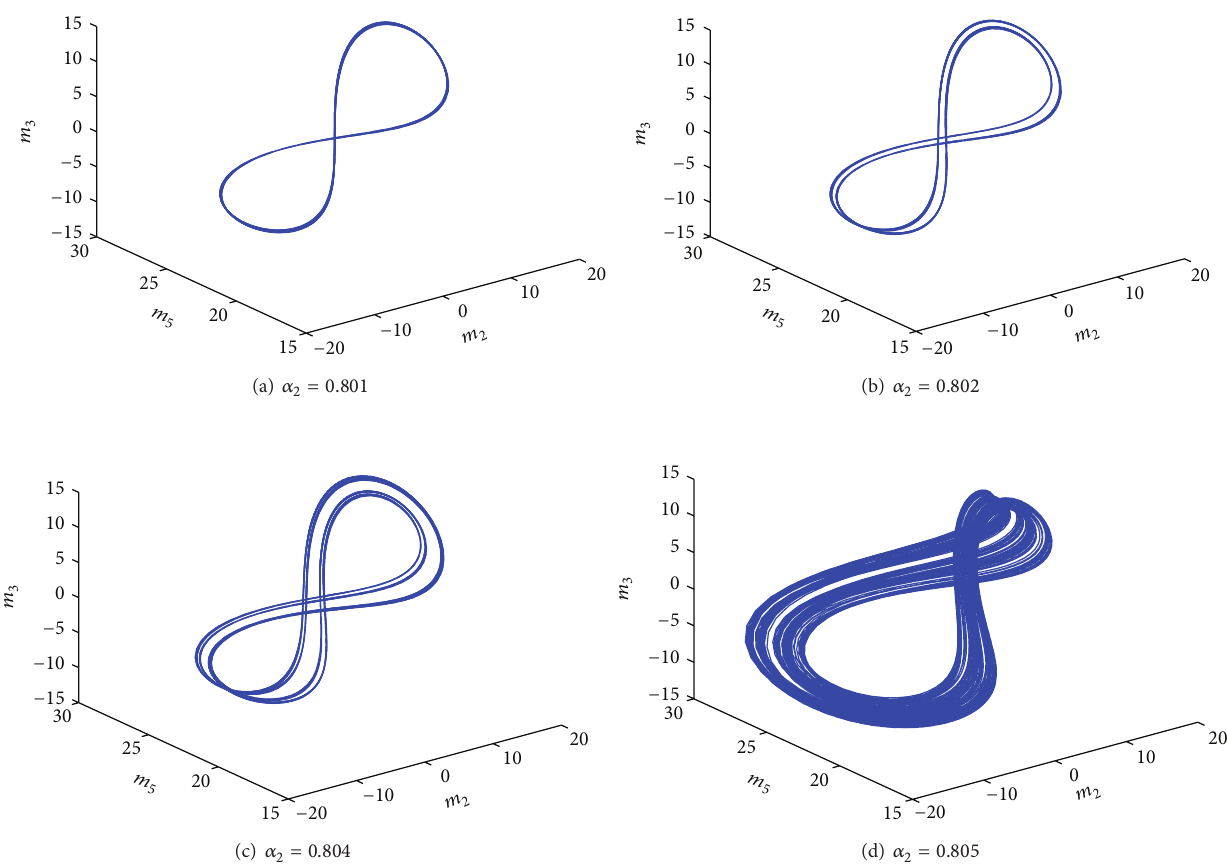
Figure 8: Phase portraits of system (6) at 𝛼 1 = 𝛼 3 = 1 with 𝛼 2